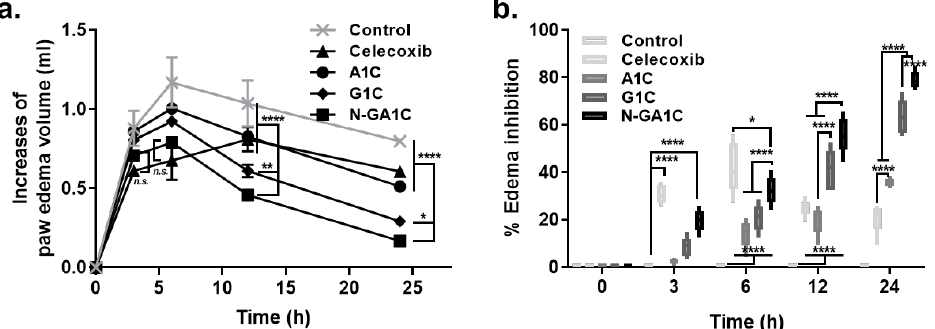
Figure 5. N-GA1C prolongs and enhances the anti-inflammatory activity of celecoxib. ( a,b ), SD rats were orally administered celecoxib (10 mg / kg), A1C (equivalent mass of celecoxib), G1C (equivalent mass of celecoxib), N-GA1C (equivalent mass of celecoxib), or IPB. ( a ), Changes in rat paw volume in each group for 24 h. ( b ), Percentage changes in edema inhibition in each group for 24 h. Data are presented as mean ± s.e.m. from a representative experiment ( n = 5) from 2 independent experiments. * p < 0.05, ** p < 0.01, and **** p < 0.0001, analyzed by two-way ANOVA with Tukey’s HSD multiple comparison post hoc test.